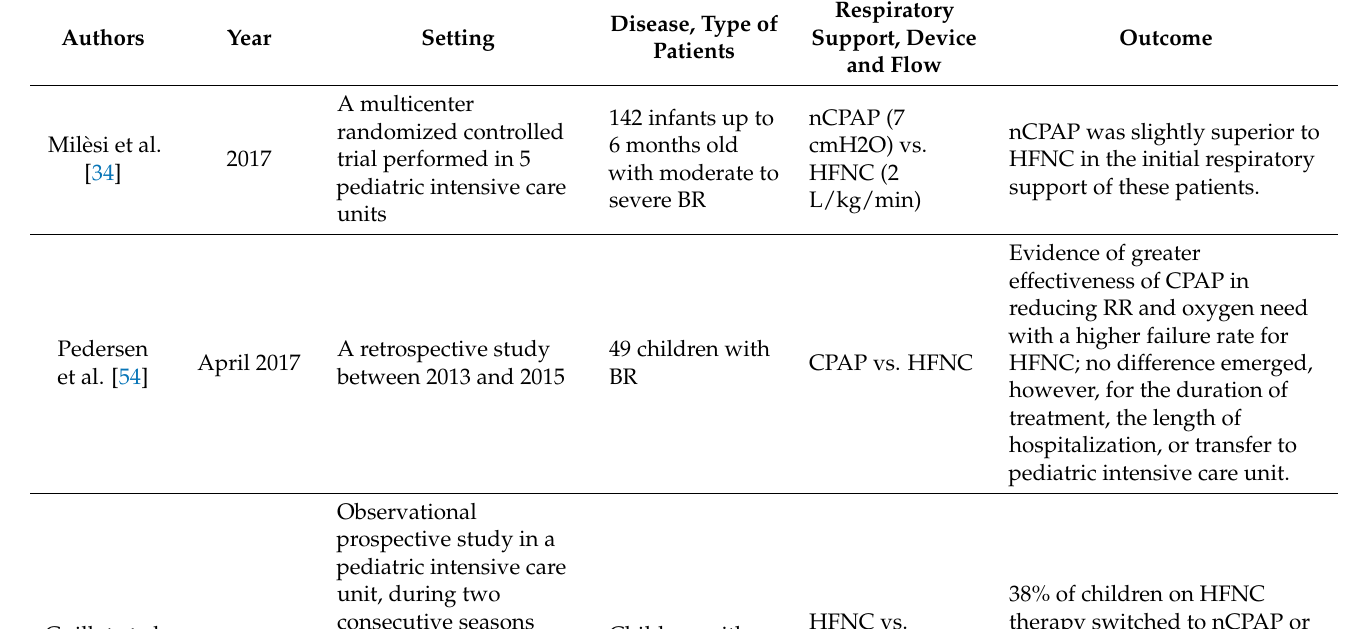
Table 3. Summary of the clinical studies that compared HFNC vs. CPAP and